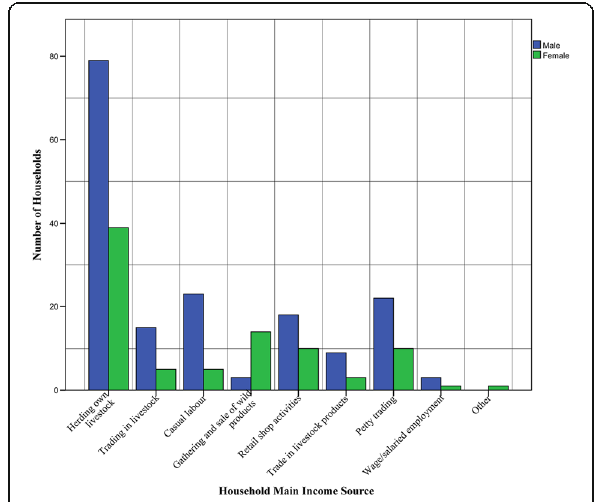
Figure 4 Primary activities of household heads (male and